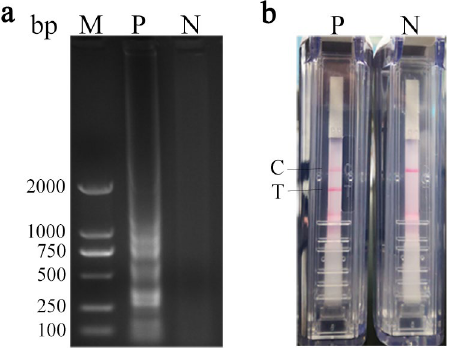
Figure 1. The basic reaction system of ALV-J CPA reaction. ( a ) Agarose gel electrophoresis of test samples; The full-length gel is presented in Supplementary Figure S17. ( b ) Nucleic acid detection strips of test samples. Lane M, DNA markers; P, ALV-J; N negative control, C control-line, T test-line.